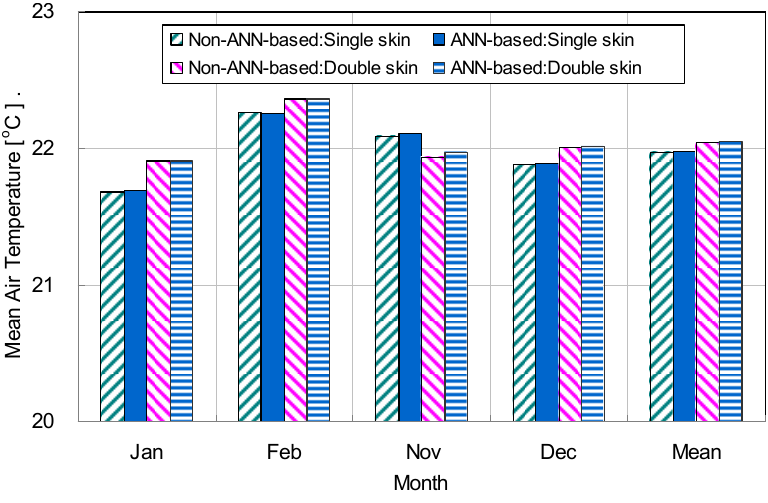
Figure 12. Mean indoor temperature by four control logic.